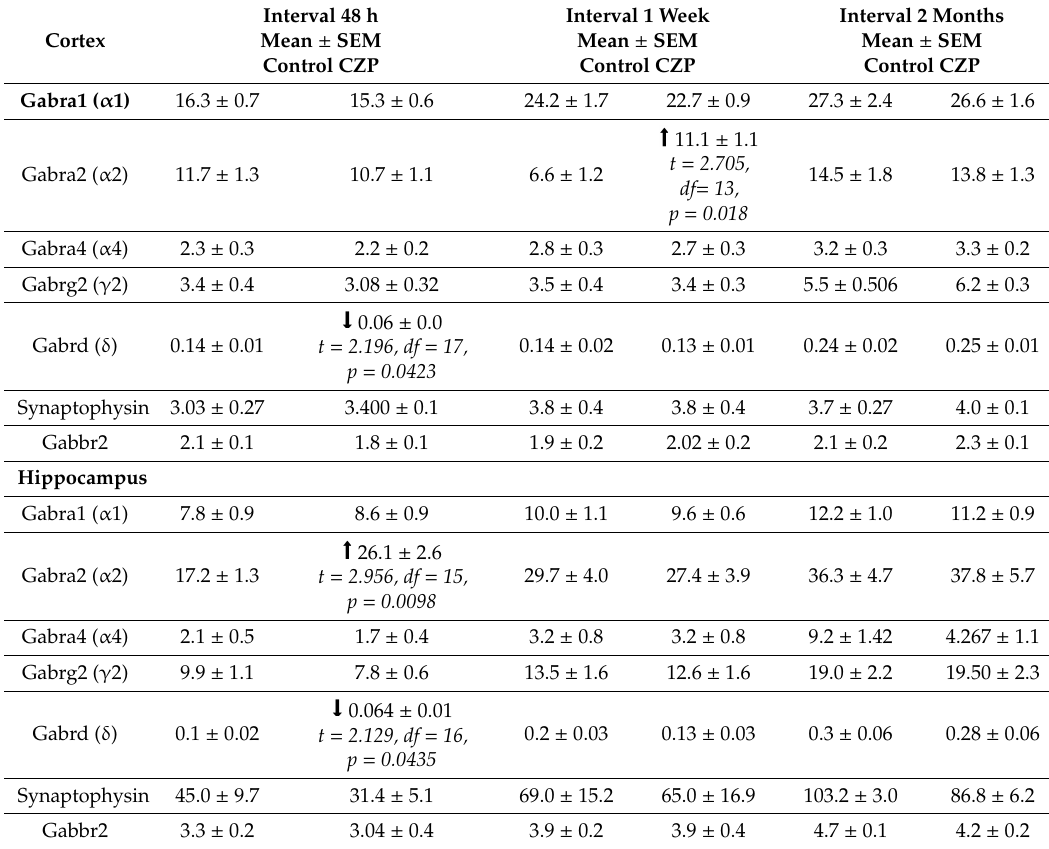
TableA1. TherelativemRNAabundanceofsynaptophysineandGABA A andGABA B